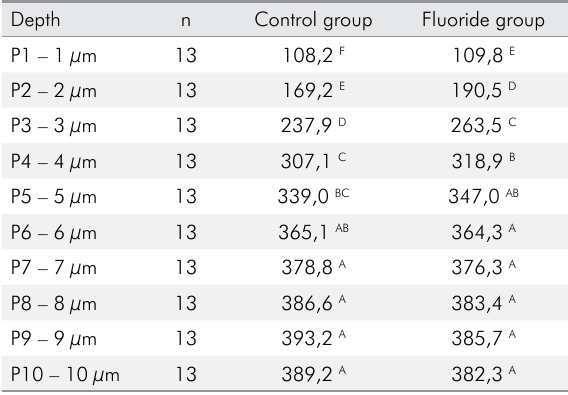
Table 2. Results of tukey test (p < 0.05) of cross-sectional nanohardness values at different depths of partly demineralized